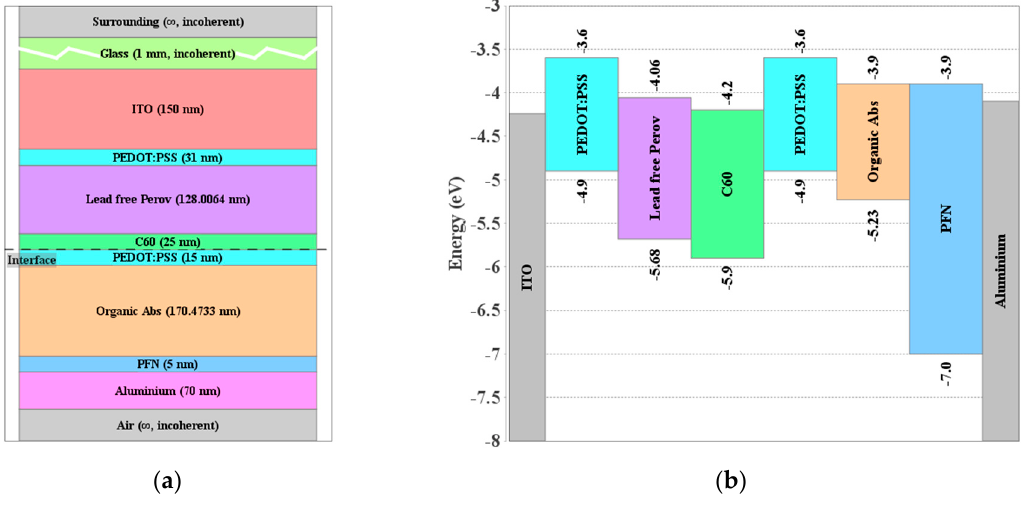
Figure 4. ( a ) Layer stack for the proposed perovskite/organic tandem cell and ( b ) energy band alignment (before contact) of materials in the cell stack.